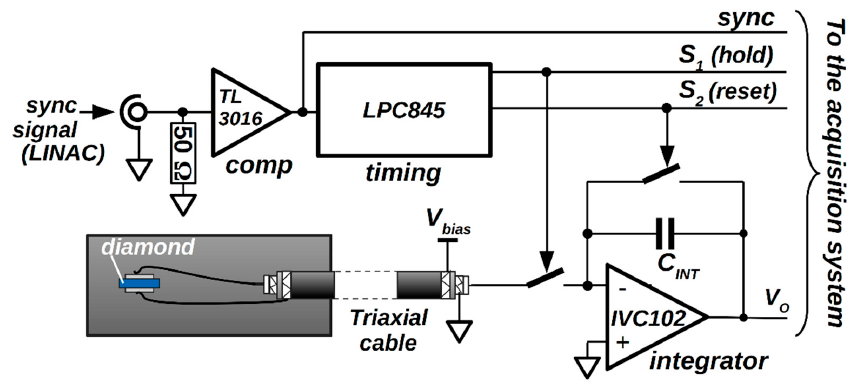
Figure 3. Block diagram of the implemented gated integrator for signal conditioning of the charge collected by the diamond